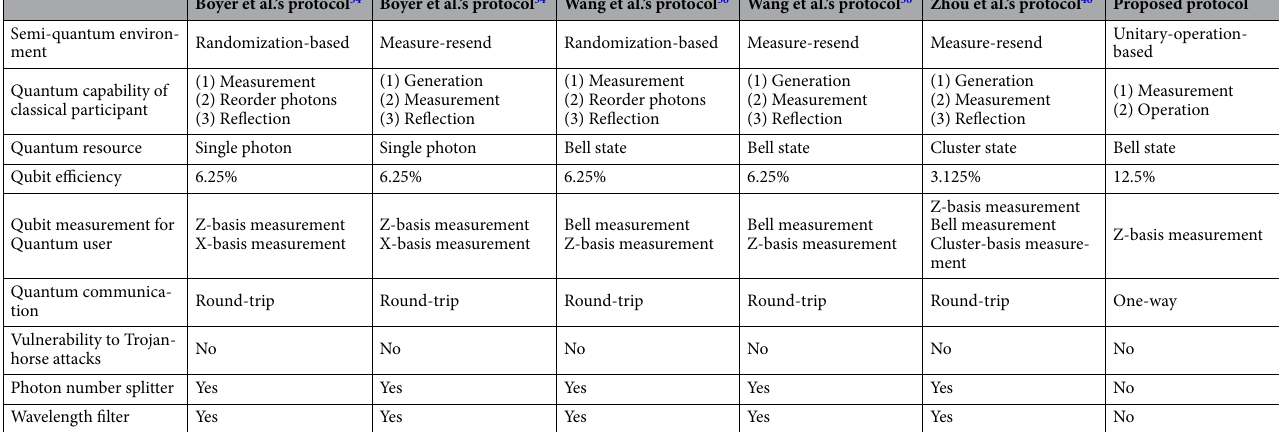
Table 3. Comparison of various parameters of Boyer et al.’s, Wang et al.’s, and Zhou et al.’s protocols and the proposed